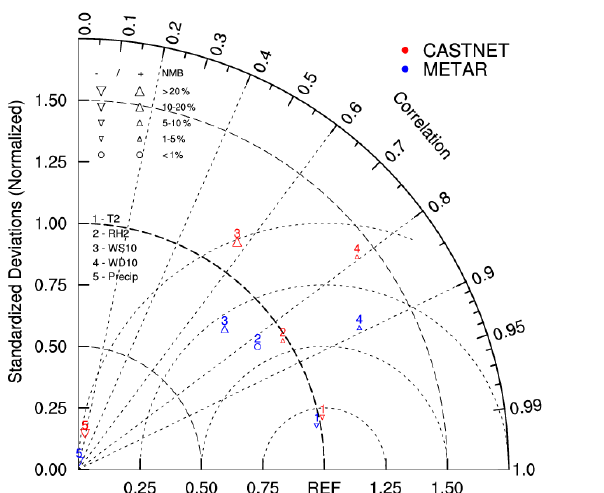
Figure 1. Taylor diagram (Taylor, 2001) with normalized standard- ized deviations (NSDs), Corr, and NMB for meteorological vari- ables ( T 2, RH2, WS10, WD10, and Precip) compared to the CAST- NET and METAR datasets. The REF marker at the x axis represents the desired performance. The closer each variable is to the REF marker, the better a performance the forecast system has for that